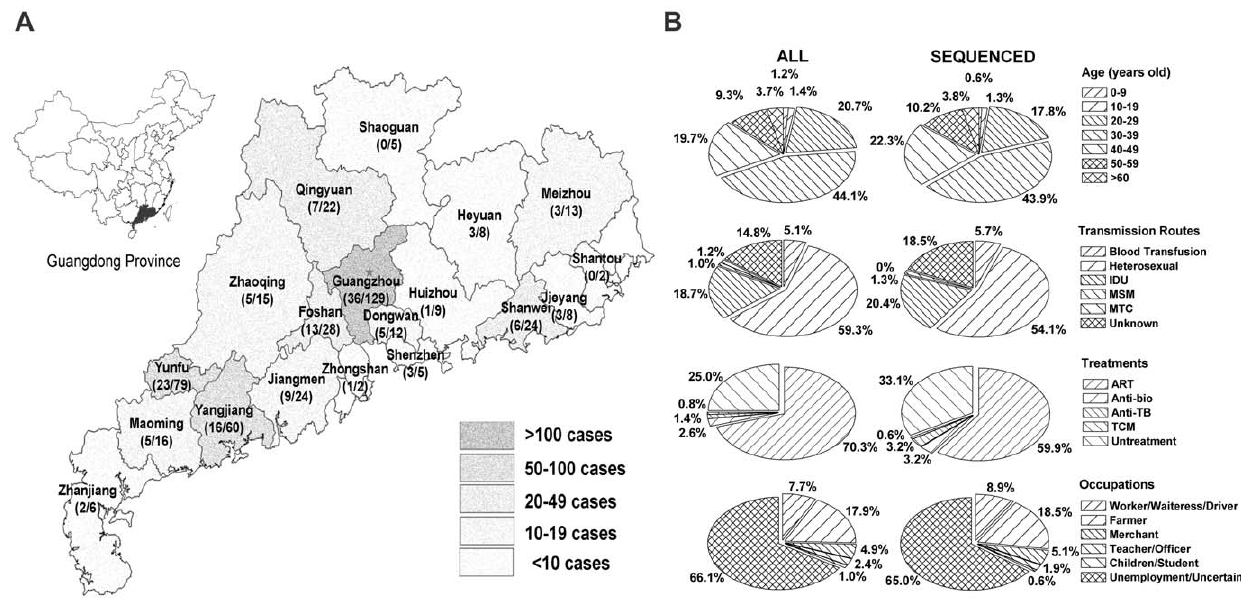
Figure 1. Characteristics of HIV-1 infected individuals in Guangzhou Hospital of Infectious Diseases in 2009. The geographical distribution of 462 patients (Guangdong’s residents) was represented by different levels of gray and the parentheses showed cases of patients enrolled in HIV-1 pol/env sequence analysis versus overall patients in this city/county (A). Comparison of characteristics between patients enrolled into the sequence analysis and overall patients, including their age, occupation, risk factors and treatments